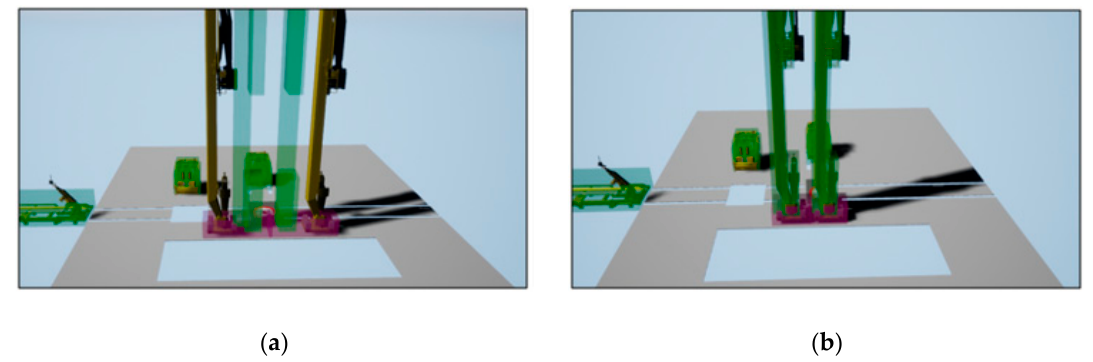
Figure 13. Results of the simulation in 2 cases of Scenario 2: ( a ) Kinematic Collision Box Algorithm ( b ) Original Collision Box.